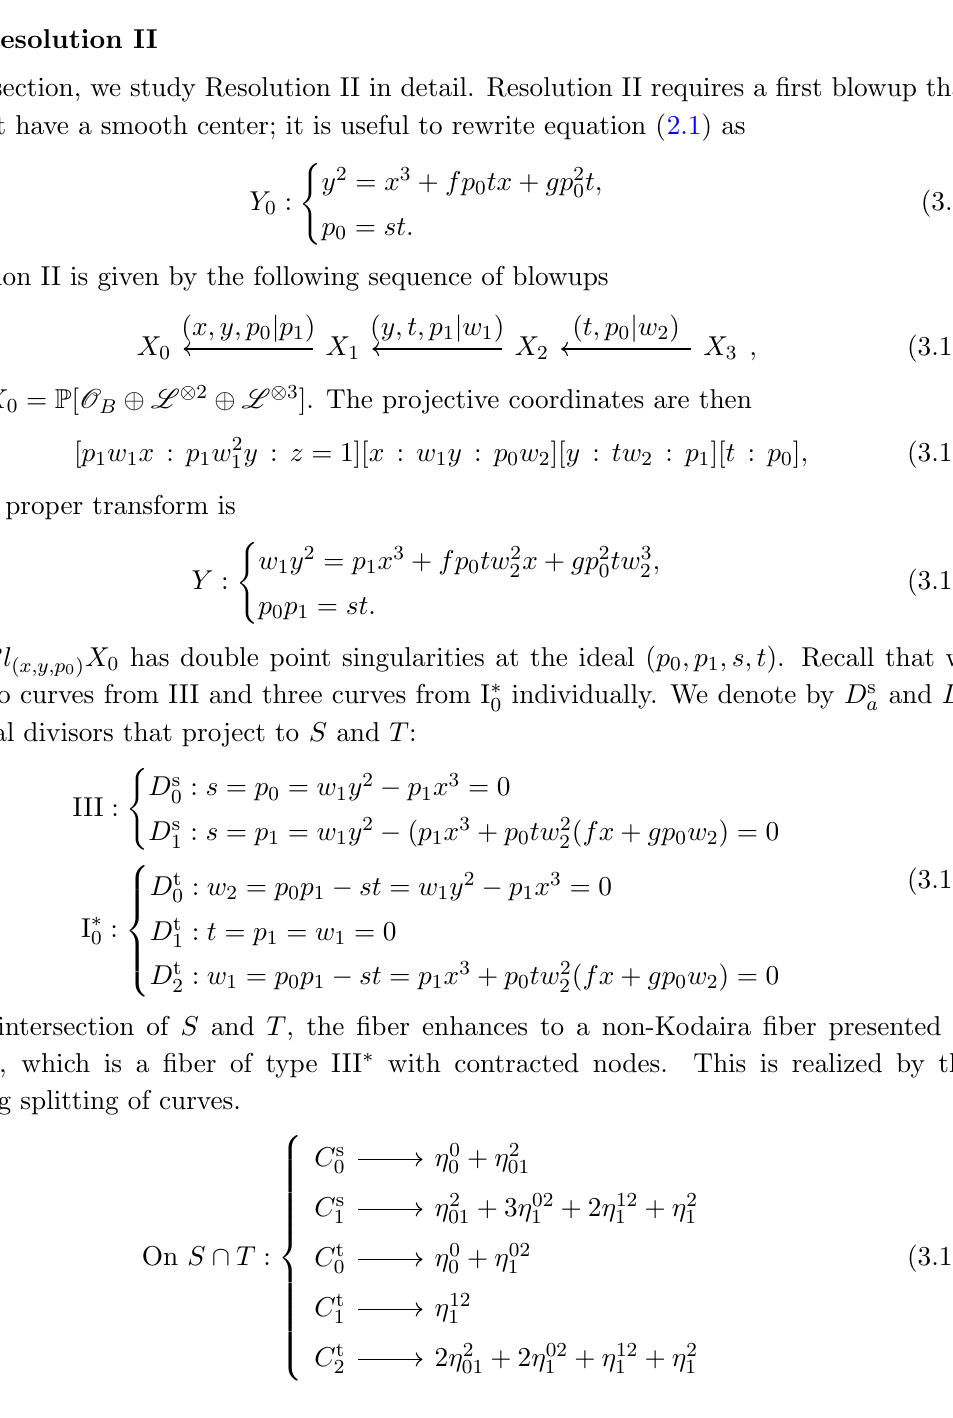
Figure 5 . Codimension-three enhancement of SU(2) (cid:2) G This (cid:12)ber is of type II (cid:3) (with dual graph e E 8 ) with contracted